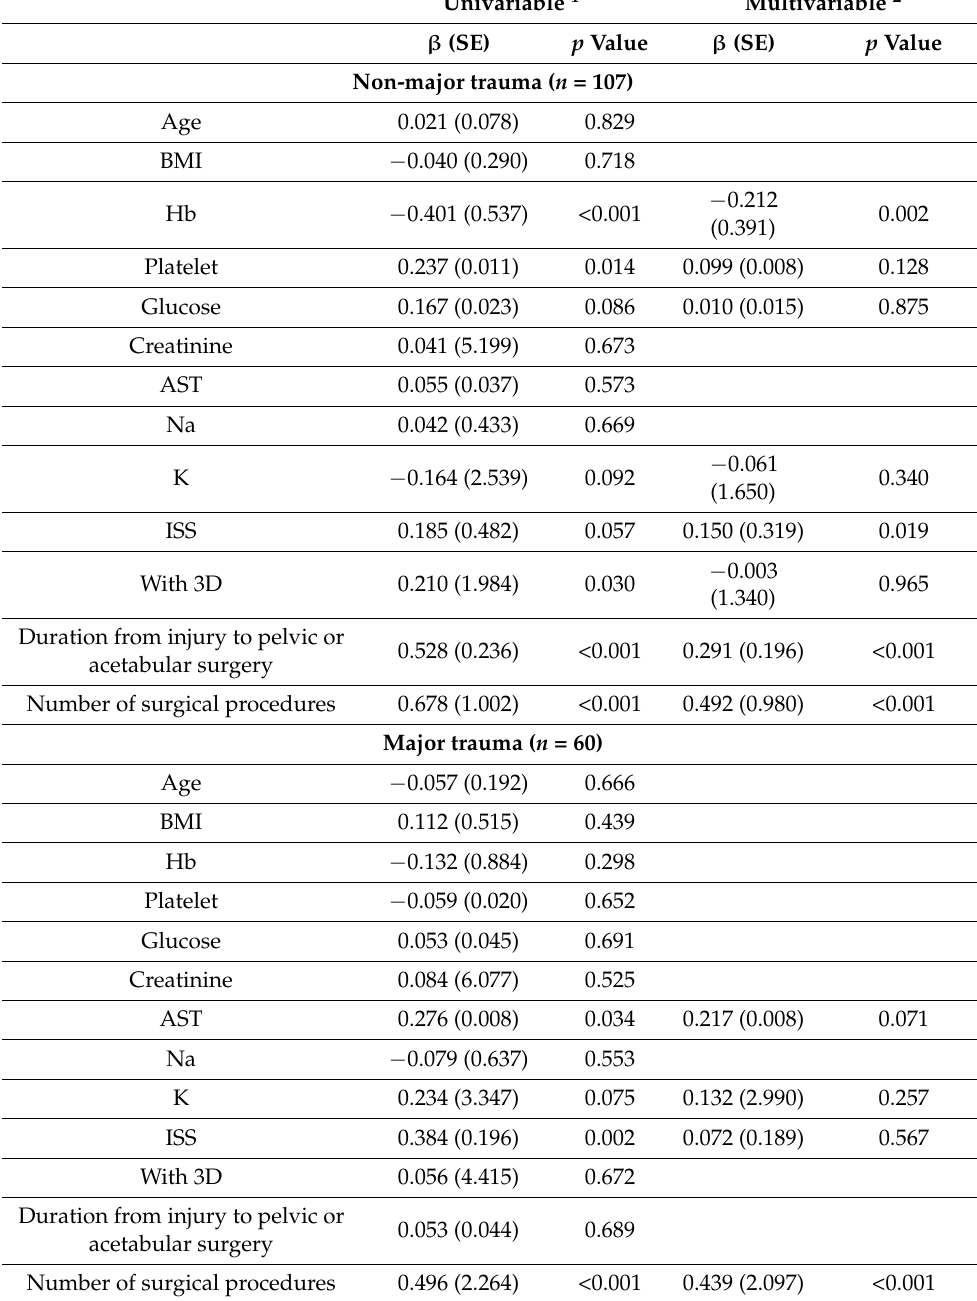
Table 4. Regression coefficients of Length of hospital stay on the measurable factors in participants with major trauma (ISS >